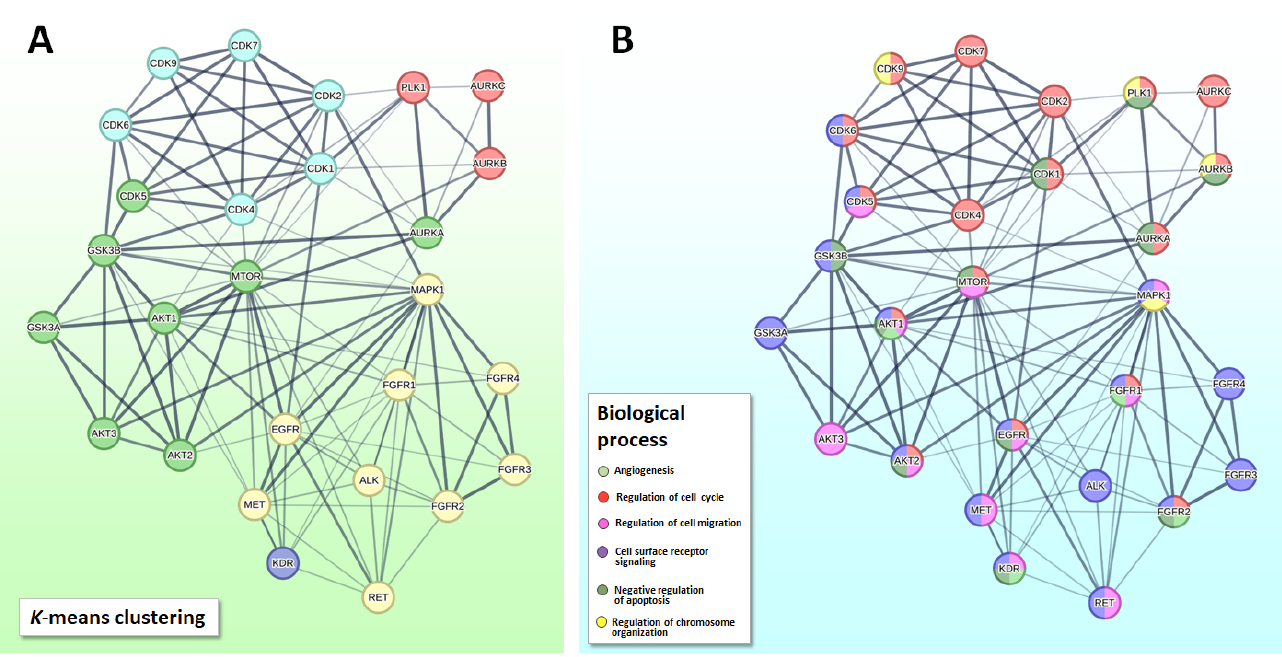
Figure 2. ( A ) Protein–protein interactions accessed through the software STRING v11.5 (available at https://string-db.org/ (accessed on 2 November 2022)). The parameters evaluated were text mining, experiments and databases. Network edges denote confidence and the minimum required interaction score was 0.700, considered high. ( A ) K-means clustering; ( B ) enrichment analysis for biological